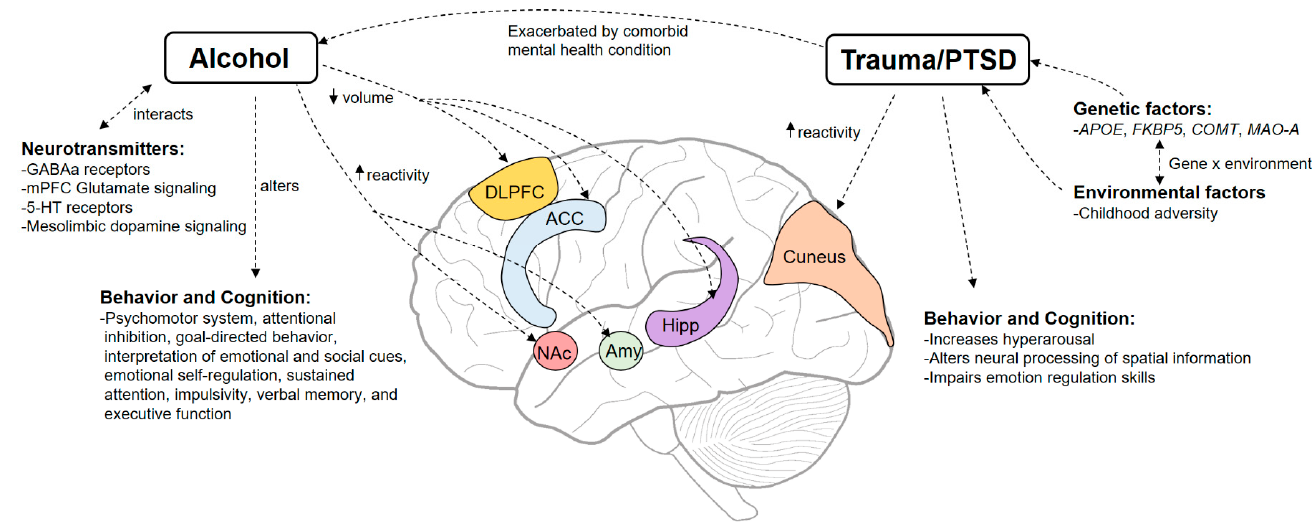
Figure 2. Mechanisms through which alcohol and trauma lead to aggressive behavior. Alcohol consumption could lead to increased aggression by interacting with neurotransmitter systems, causing structural or functional changes in certain brain regions, or altering certain aspects of behavior and cognition. Alcohol consumption can be precipitated by trauma exposure and is exacerbated in individuals with comorbid mental health conditions. Genetic factors can interact with environmental factors, such as childhood adversity to increase the likelihood of developing PTSD. Trauma exposure, in turn, can lead to functional changes in brain regions and lead drastic changes in behavior and cognitive functions. Abbreviations: Anterior Cingulate Cortex (ACC); Amygdala (Amy); Dorsolateral prefrontal cortex (dlPFC); Hippocampus (Hipp); Medial Prefrontal Cortex (mPFC); Nucleus Accumbens (NAc).